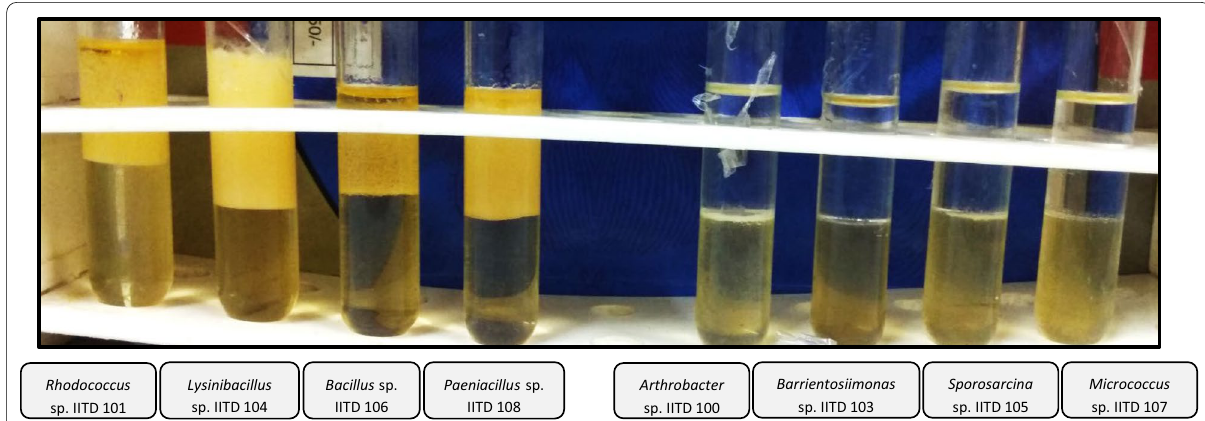
Fig. 5 E 24 assay for determination of biosurfactant production by members of consortium